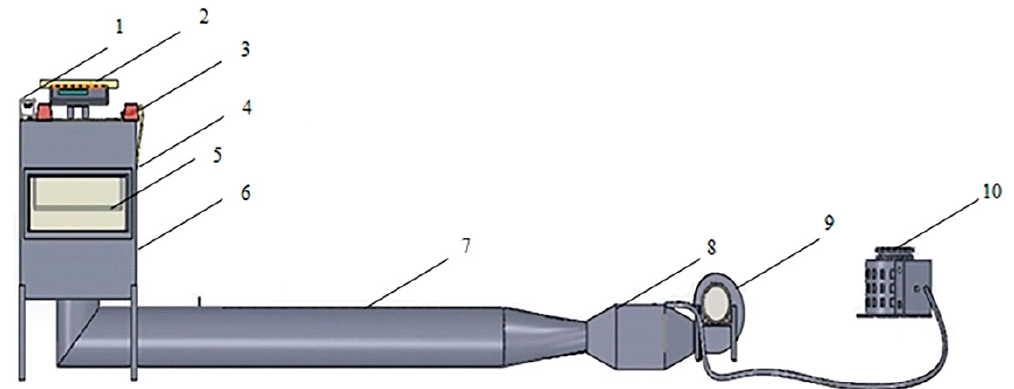
Figure 1. Setup (1. Hygrometer [HTC-1], 2. Precision scale (AVERY BERKEL, Model CC061), 3. Thermometer-Anemometer [KIMO], 4. Outlet, 5. Tray, 6. Chamber, 7. Air flow channel, 8. Heating system, 9. Fan [SB908AN-22-3], 10. Variac [STACO 3PN1520B]).